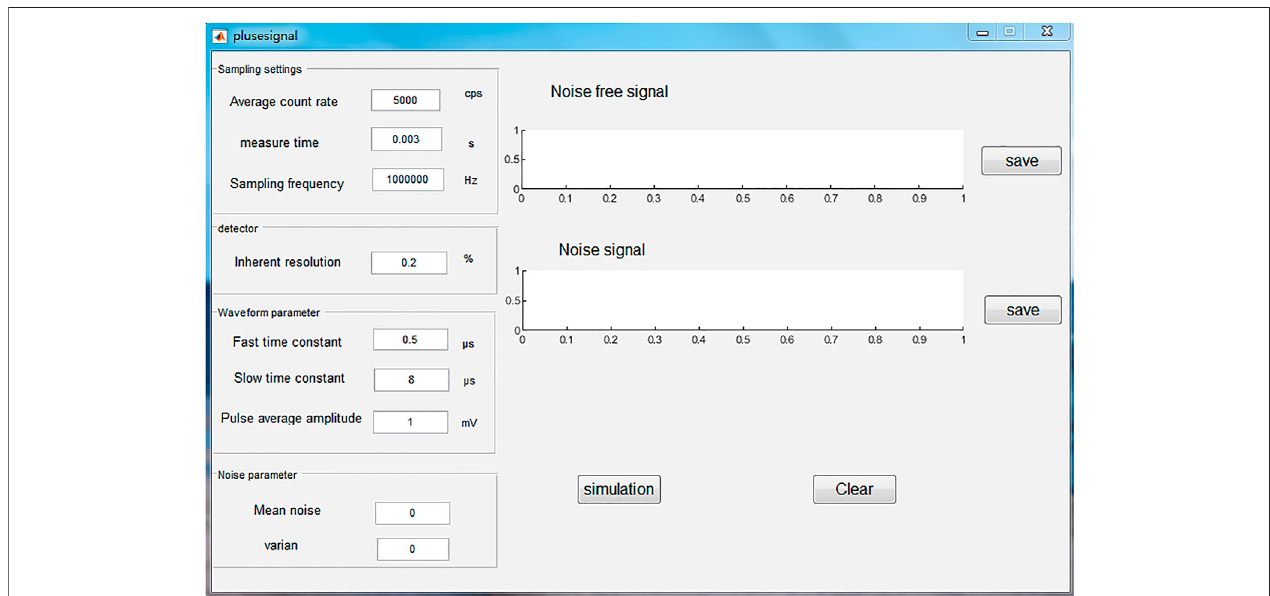
FIGURE 2 | Simulation GUI interface of the nuclear signal.